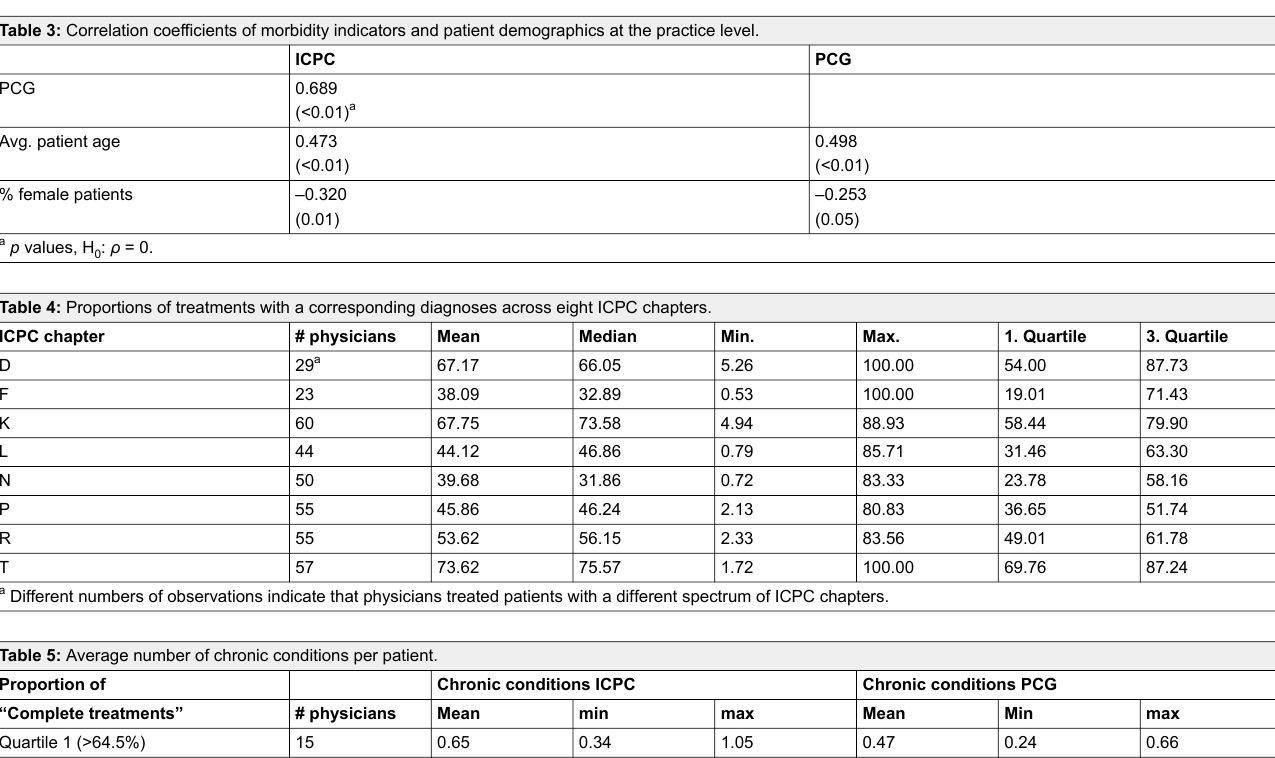
Variation of average number of PCG based chronic conditions per patient across 60 primary care practices. a The horizontal line denotes the overall averages of PCG at the practice level, dotted lines the first and third quartile. Error bars show the 95% confidence interval of PCG based morbidity estimates of practices.